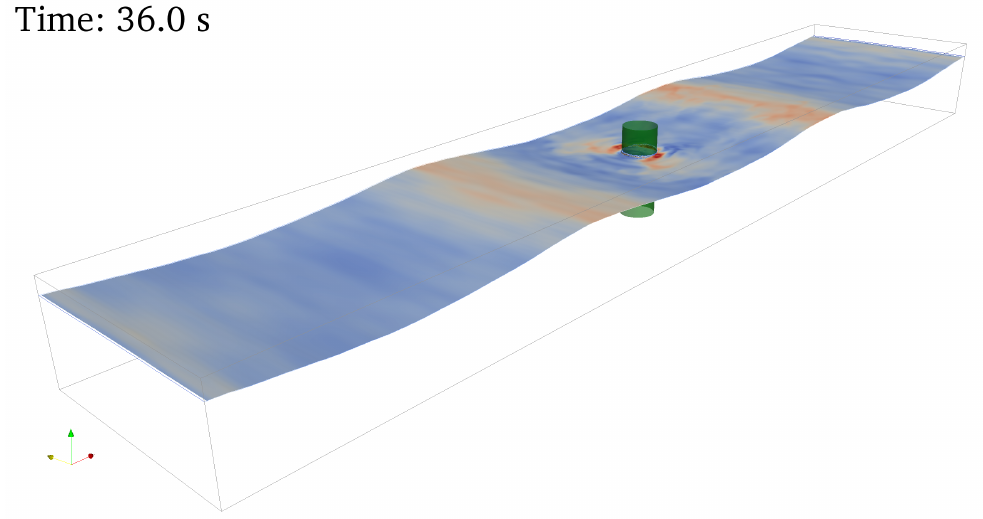
Figure 4. Snapshot of the 3D model where the porous cylinder is represented by orthotropic porous media. An animation of the wave-structure interaction is available as supplementary